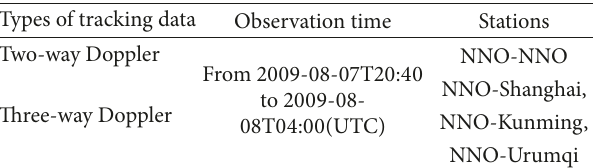
Table 1: MEX orbital tracking data.